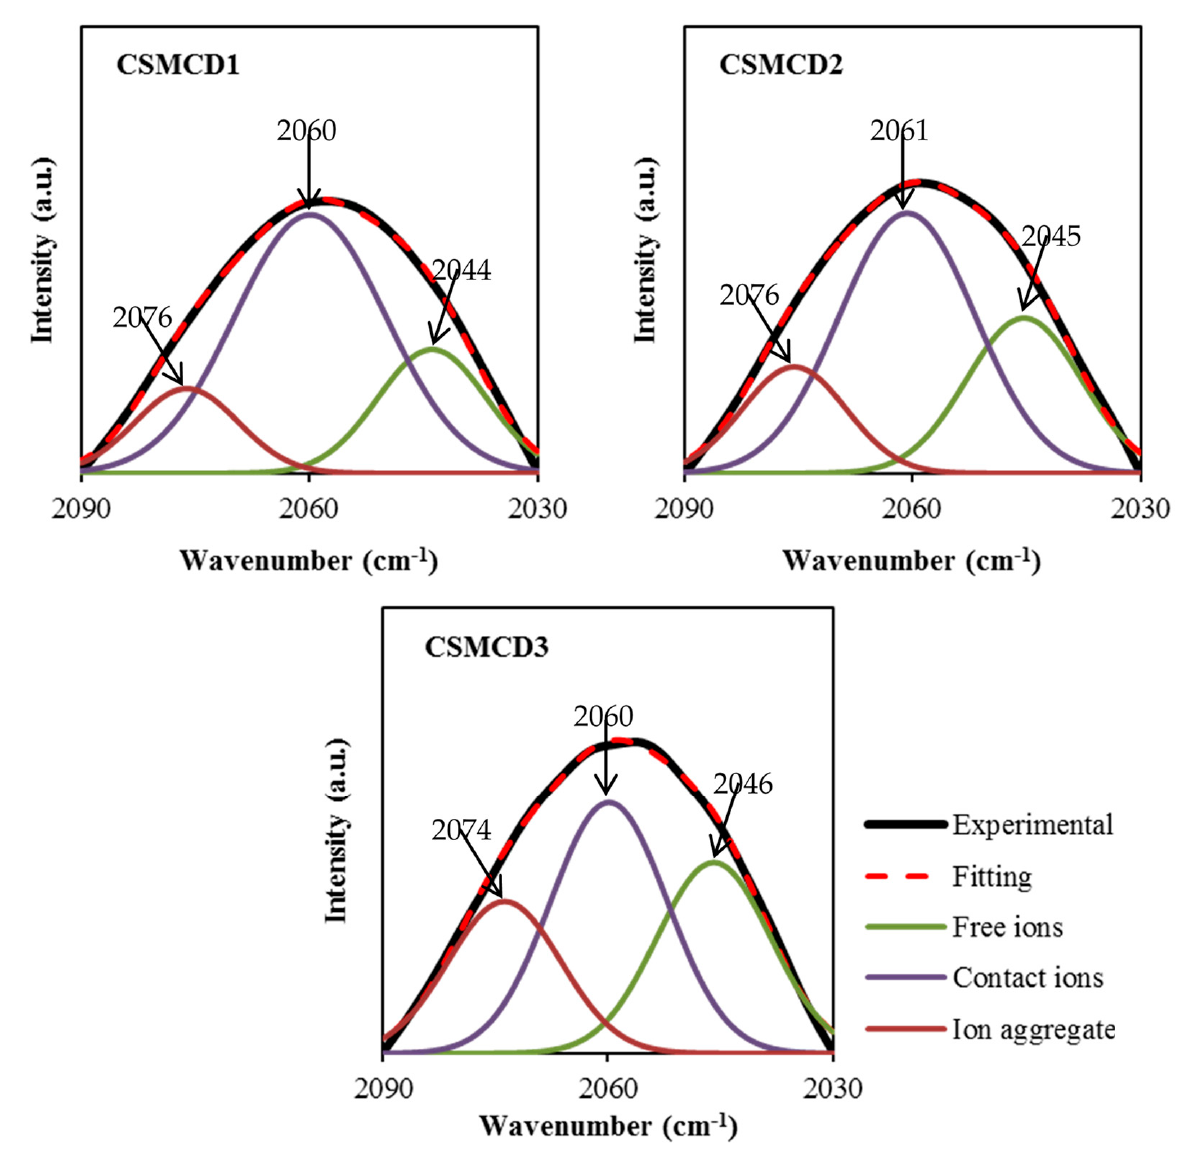
Figure 3. Deconvoluted FTIR spectra at 2030–2090 cm − 1 .